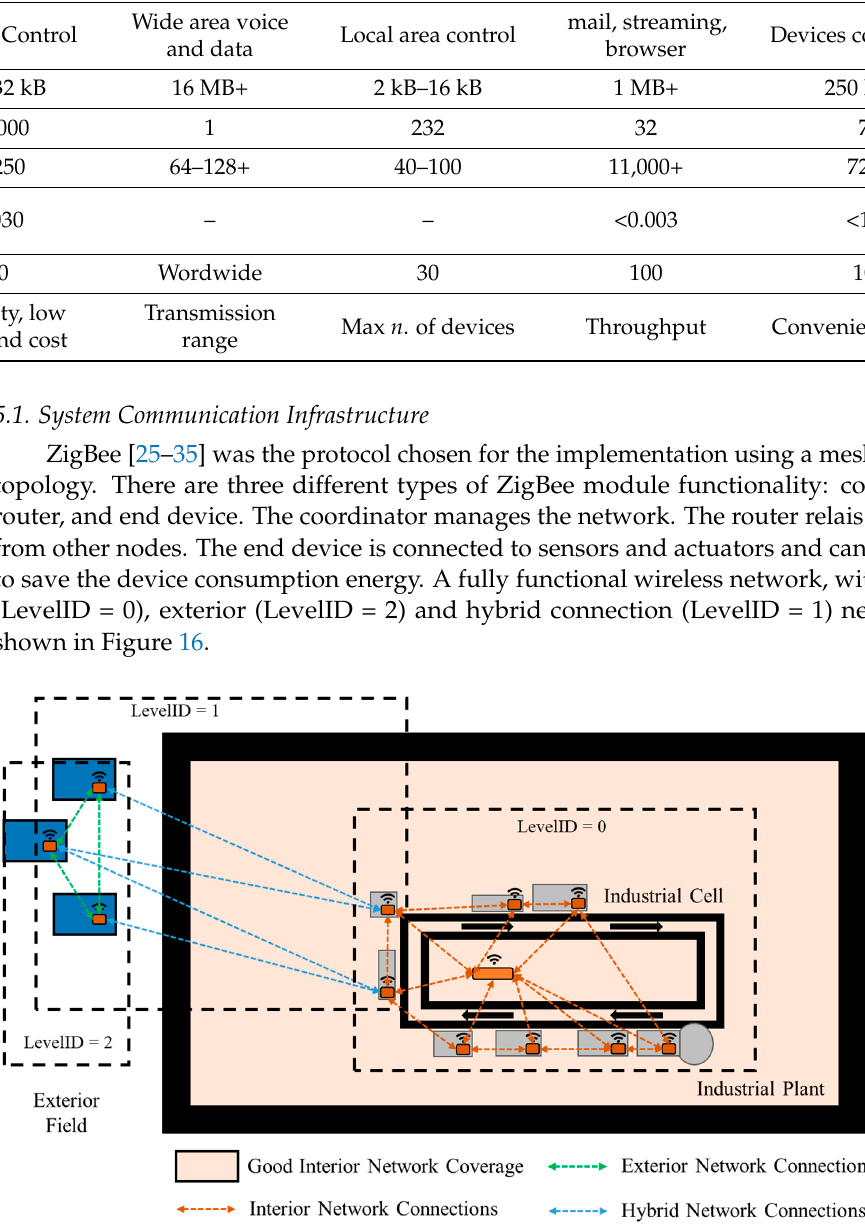
Figure 16. Fully functional industrial wireless network.